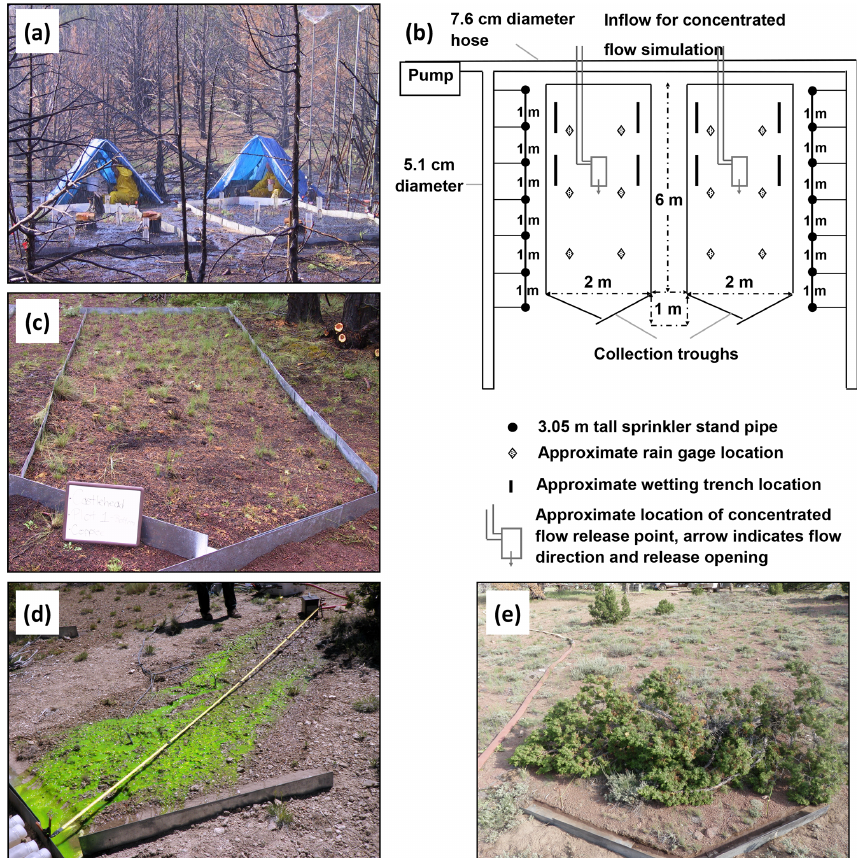
Figure 2. Images showing paired large rainfall plots during rainfall simulations (a) , experimental setup of paired large rainfall plot simulation experiments (b) , a fully bordered large rainfall simulation plot on a tree coppice microsite (c) , a borderless overland-flow simulation plot and experiment on an intercanopy (shrub–interspace) microsite (d) , and a borderless overland-flow simulation plot with a cut, downed tree on an intercanopy microsite (e) , all as respective examples as applied in this